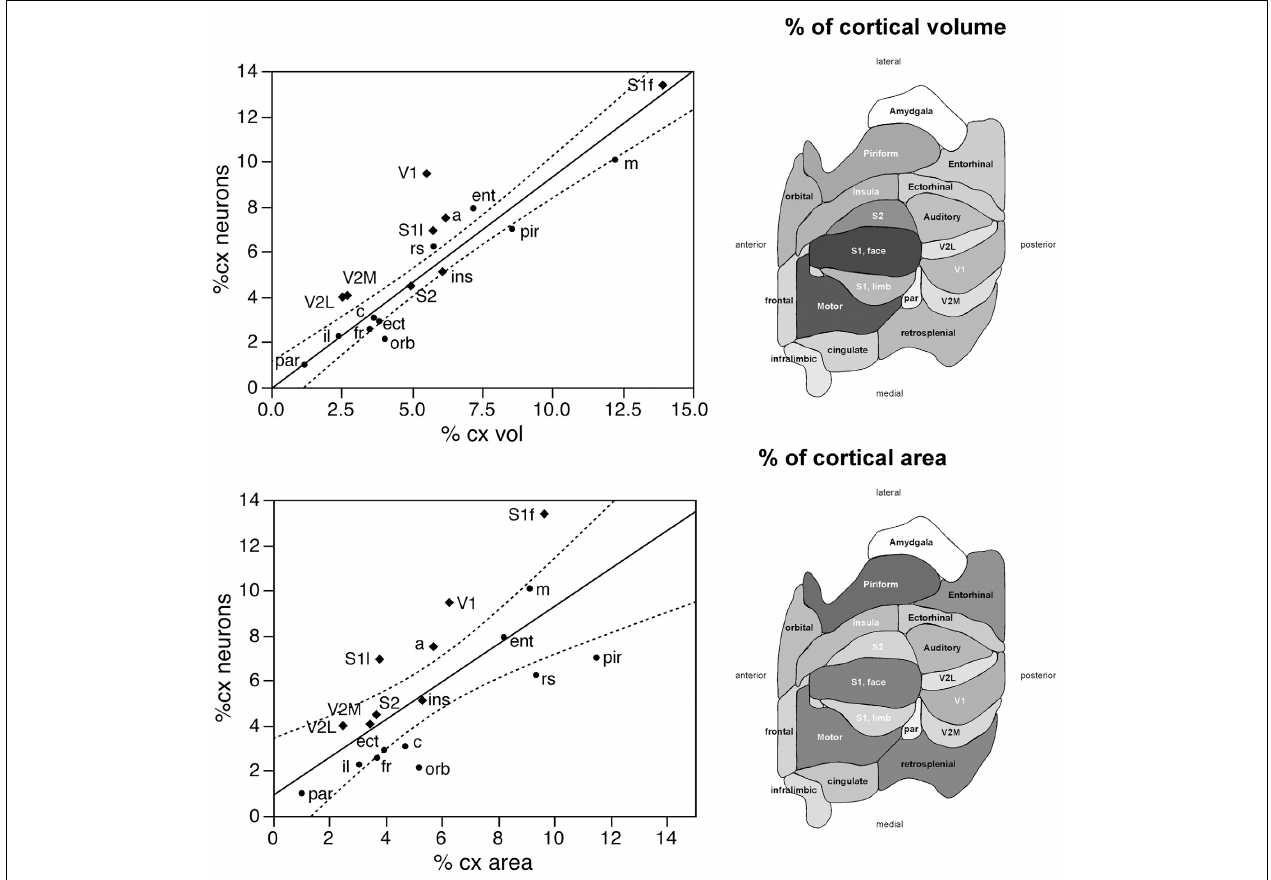
FIGURE 3 | The relative number of cortical neurons found in each functional area correlates well with the relative volume of each area, but poorly with the relative surface area of each functional area. Top left, relative number of cortical neurons in each area plotted as a function of the relative volume of that functional area. The fitted line is the linear function that describes the entire dataset, including areas V1, V2L, and V2M, whose respective datapoints fall well outside of the 95% confidence interval (dotted lines). Top right, variation in